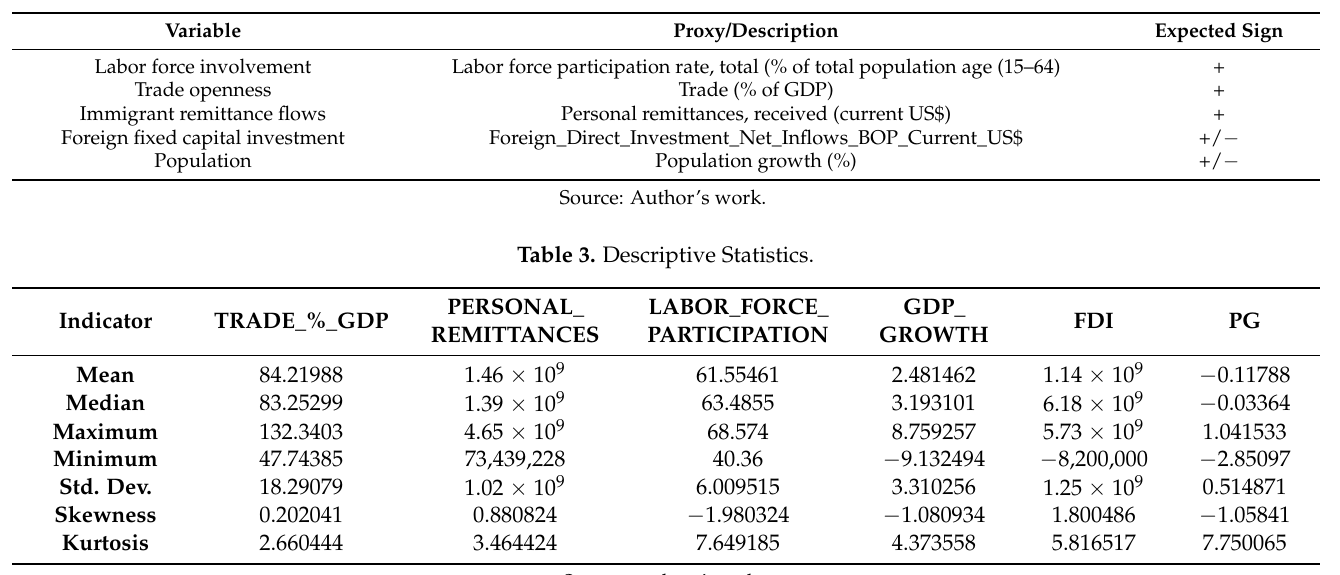
Table 2. Explanatory variables and the expected relationship.